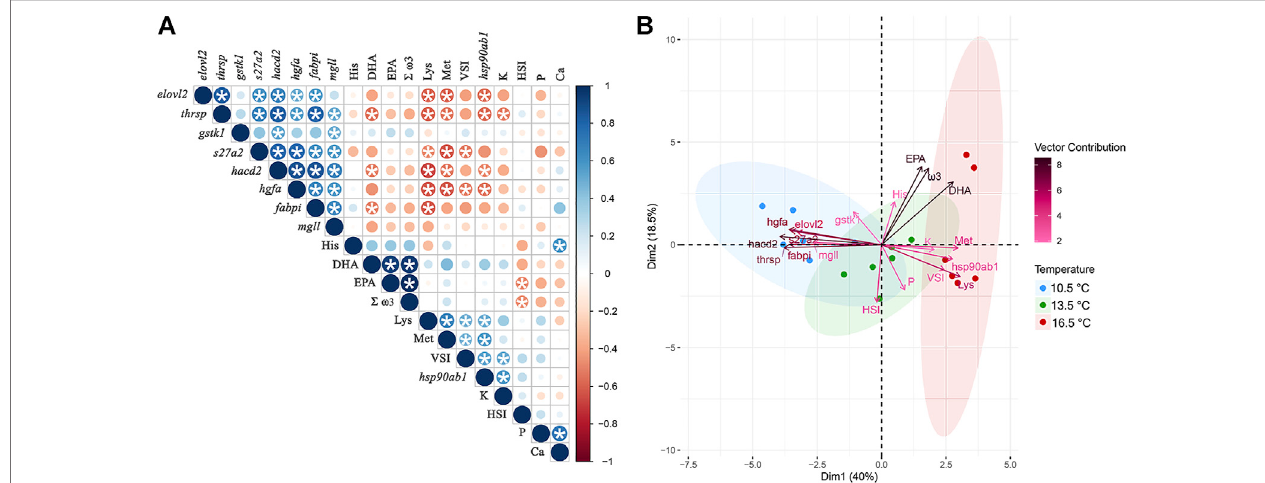
FIGURE 8 | (A) Correlogram of expression pro fi les for all transcripts used for RT-qPCR validation alongside fi llet fatty acid ( ω 3, total omega-3; DHA, docosahexaenoic acid; EPA, eicosapentaenoic acid), amino acid (Lys, lysine; Met, methionine; His, histidine), and mineral (P, phosphorus; Ca, calcium) compositional resultsand phenotypic(HSI,hepatosomaticindex;VSI,viscerosomaticindex;K,conditionfactor)measurementdataamongstall fi sh.Thecolouredscaleshowsdegree ofcorrelationrangingfrom r = − 1.0 (red) to r =1.0 (blue). The sizeofthe coloured circle indicates its signi fi cance level and circles containingasterisksare signi fi cant at p < 0.05. (B) Principal component analysis(PCA) of the samemultivariate dataset with distinction between rearing temperature treatments based on their phenotypic characteristics and transcript expression. Variable eigenvectors are coloured based on their contribution to Dimension (Dim) 1 and 2 of the PCA